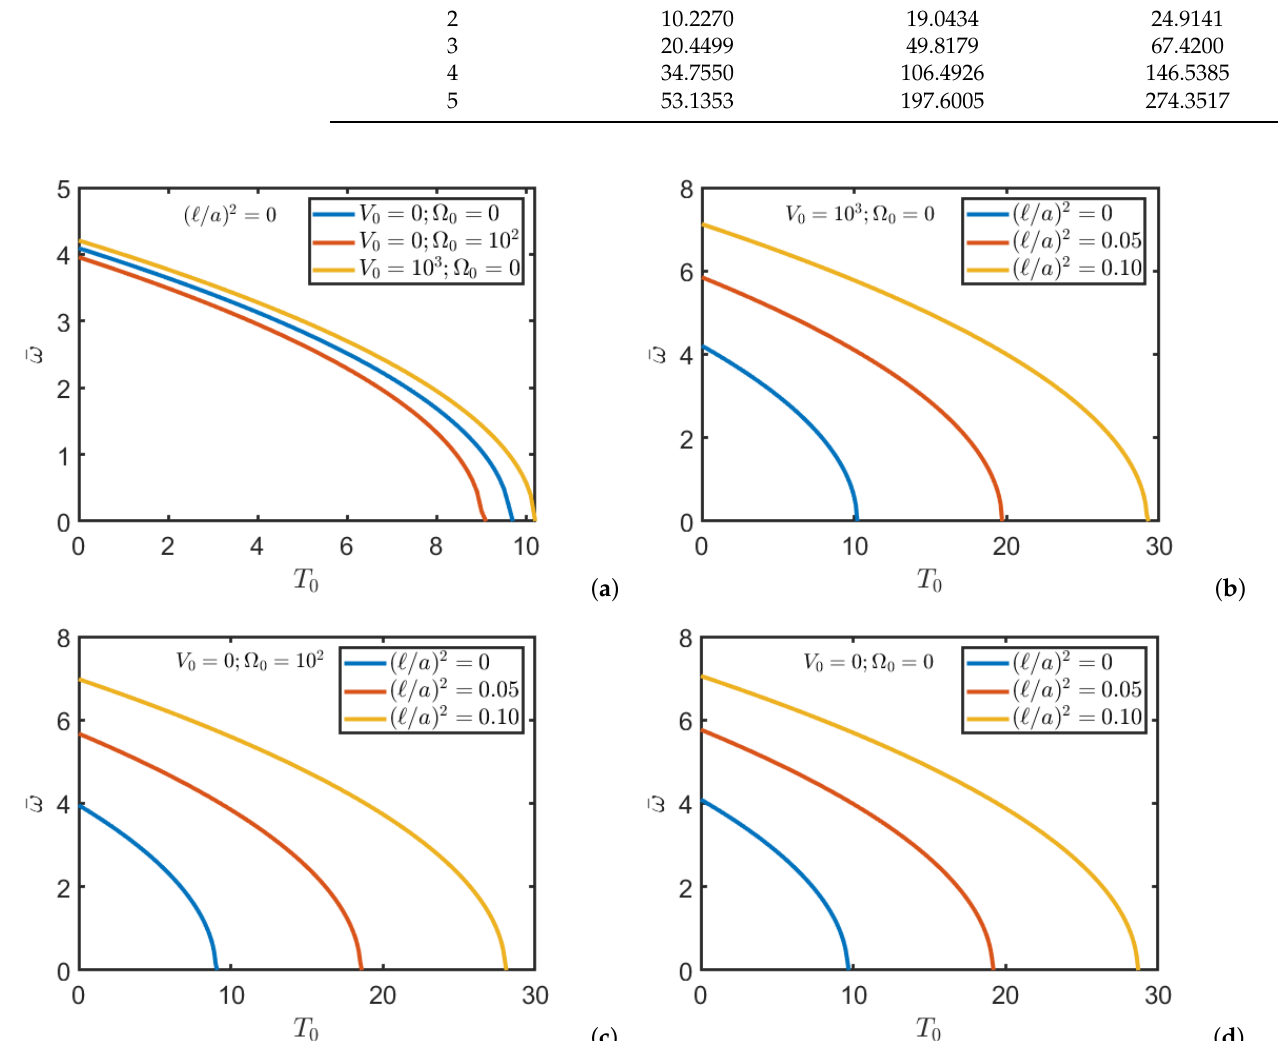
Figure 5. Natural frequencies ¯ ω of a simply supported square FG nanoplate composed by BaTiO 3 /CoFe 2 O 4 to vary of temperature T 0 and for different values of magnetic and electric potentials and non-local parameter: ( a ) local configuration ( (cid:96) = 0); ( b ) nonlocal configuration with V 0 (cid:54) = 0; ( c ) nonlocal configuration with Ω 0 (cid:54) = 0; ( d ) nonlocal configuration with V 0 = Ω 0 =